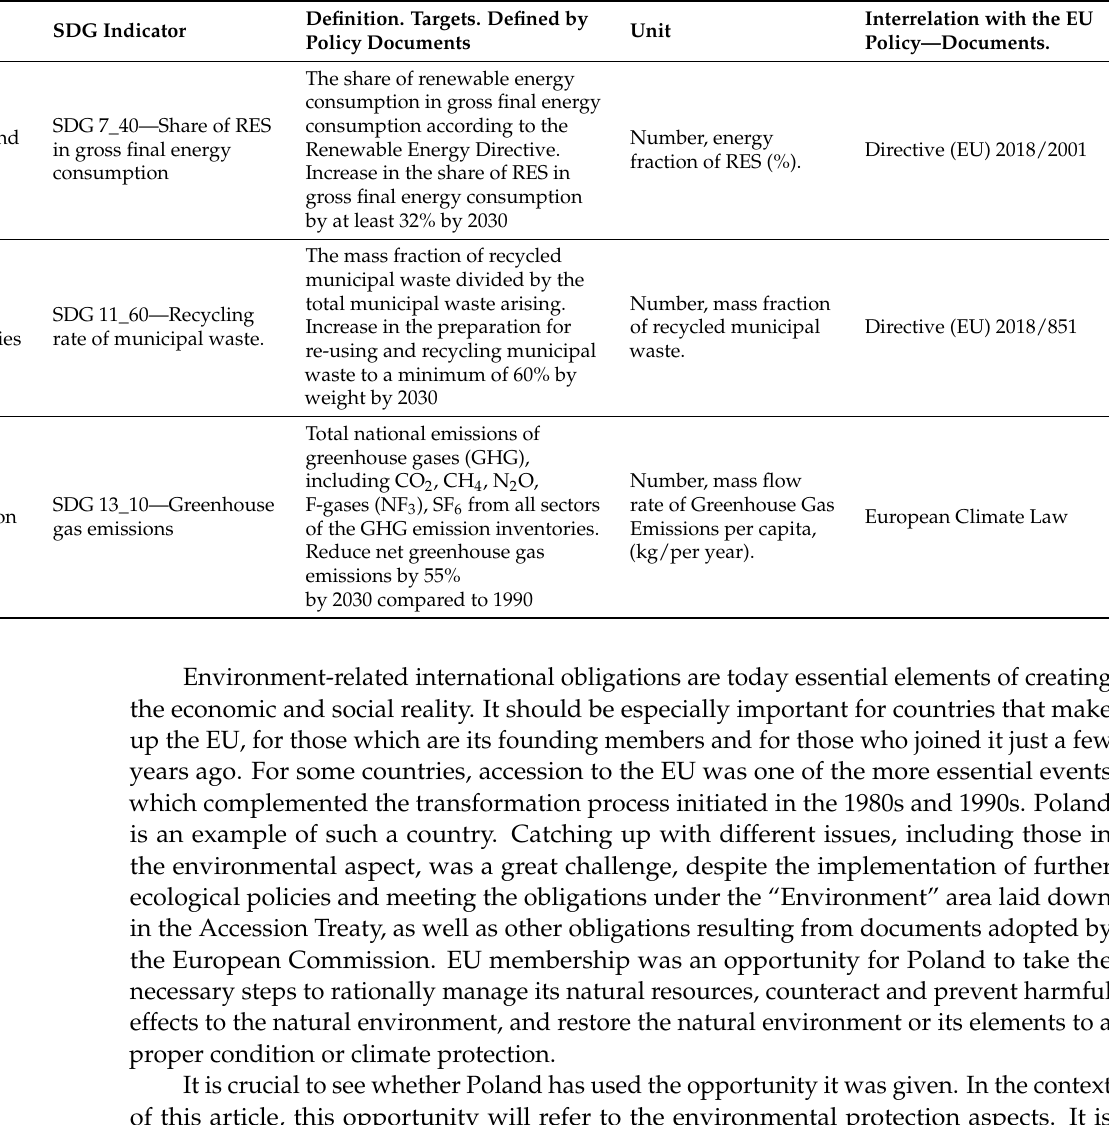
Interrelation with the EU Unit